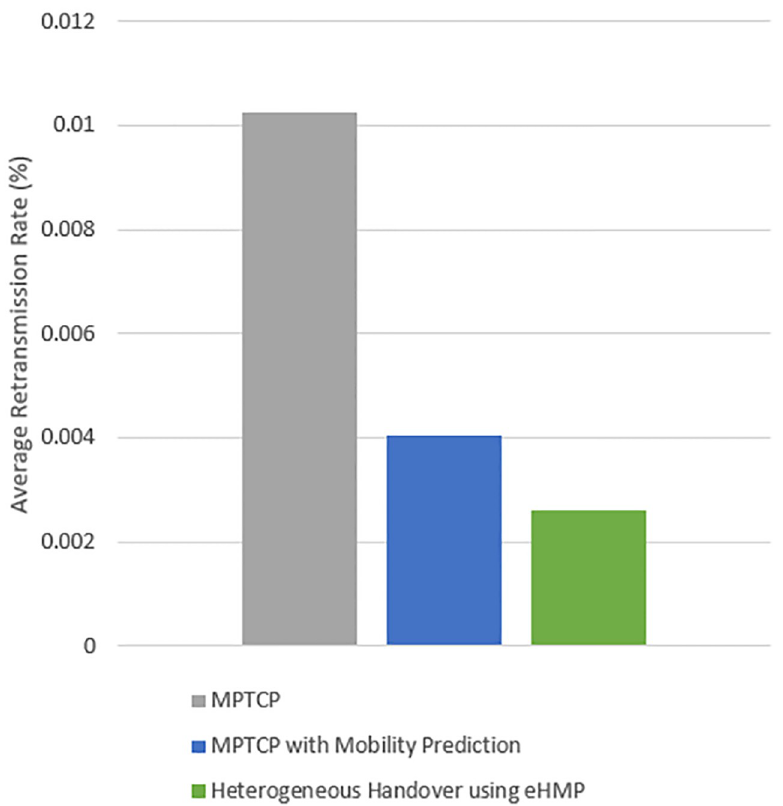
Fig 31. The average retransmission rate using the proposed eHMP, MPTCP and MPTCP with mobility prediction.